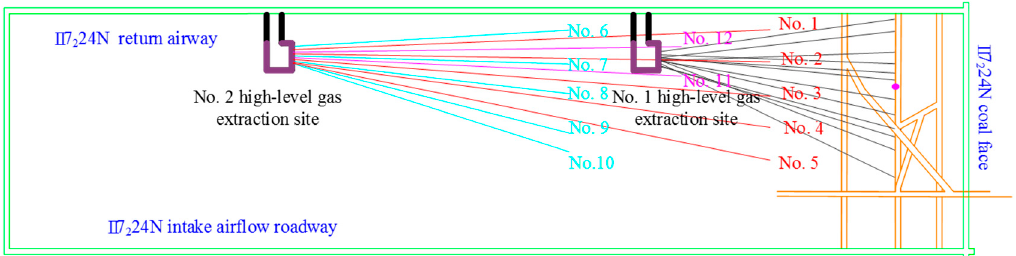
Figure 14. High-level gas extraction site layout diagram of the II 7 2 24N fully mechanized face.